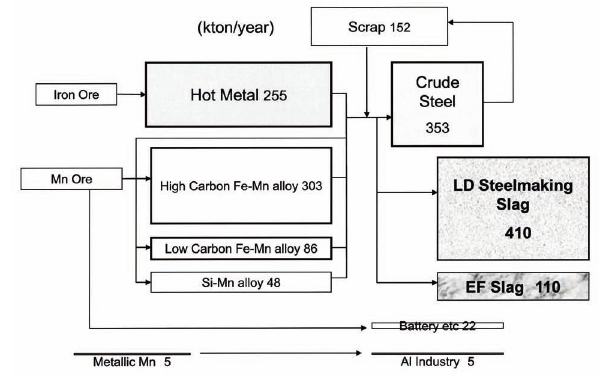
Figure 1. Material flow of manganese in Japan